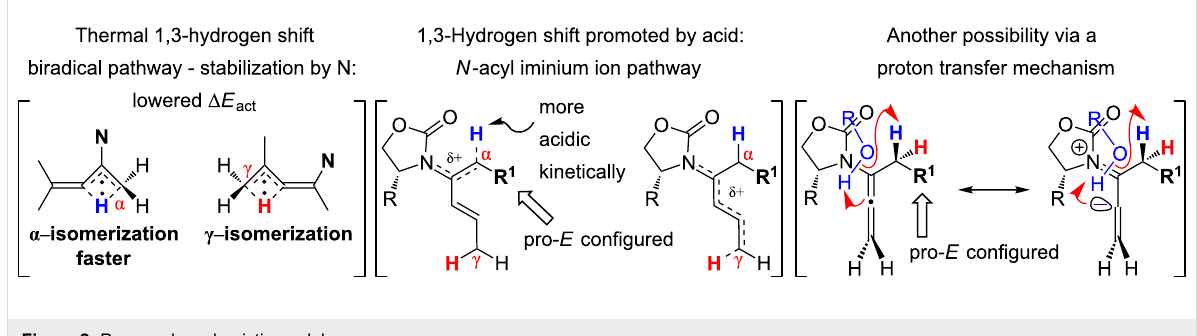
Figure 2: Proposed mechanistic models.